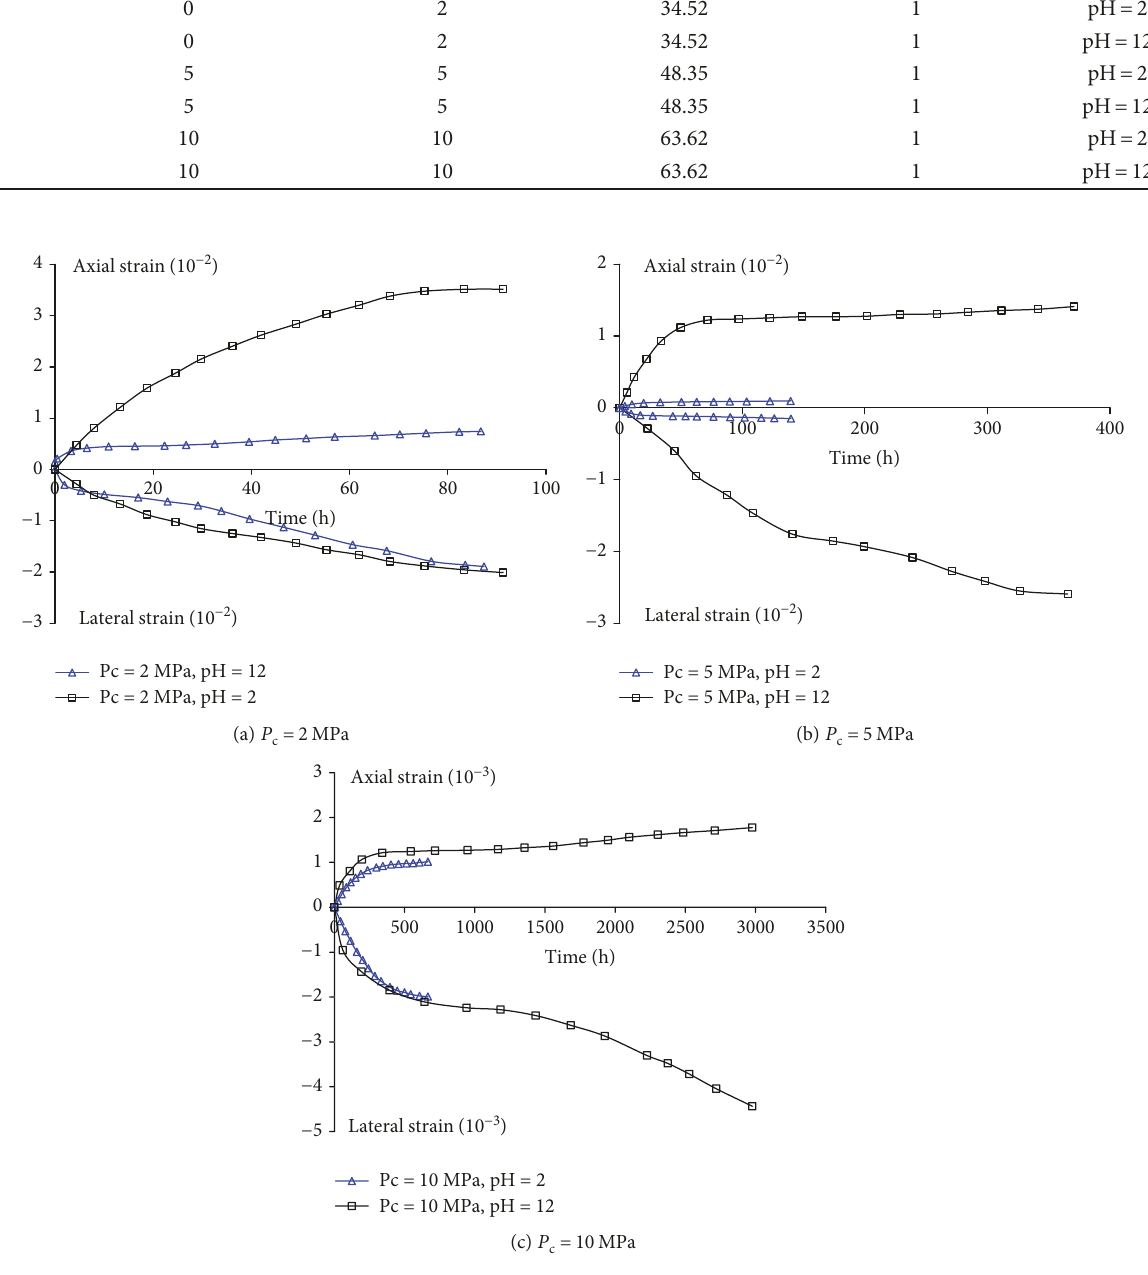
Figure 5: Creep strain evolutions of the cracked samples under di ff erent con fi ning pressures and reactive solution